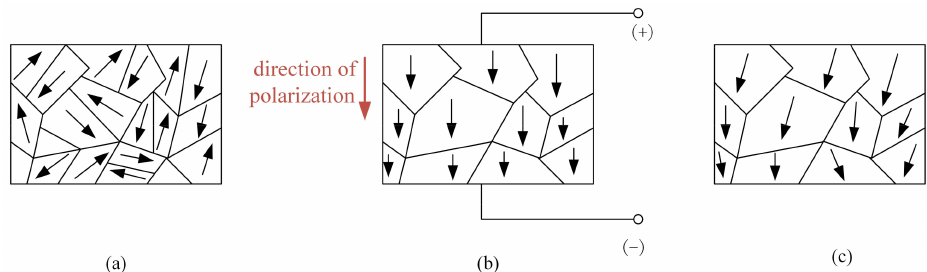
Figure 1. Schematic diagram of polarization process of piezoelectric actuator. ( a ) Before polarization; ( b ) during polarization; ( c ) after the